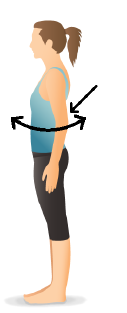
Figure 13. Exercise: Rounded back—hollow back. A periodic movement with a variation of ± 45 ◦ on the roll axis can be observed. The pitch and yaw axis are stable.